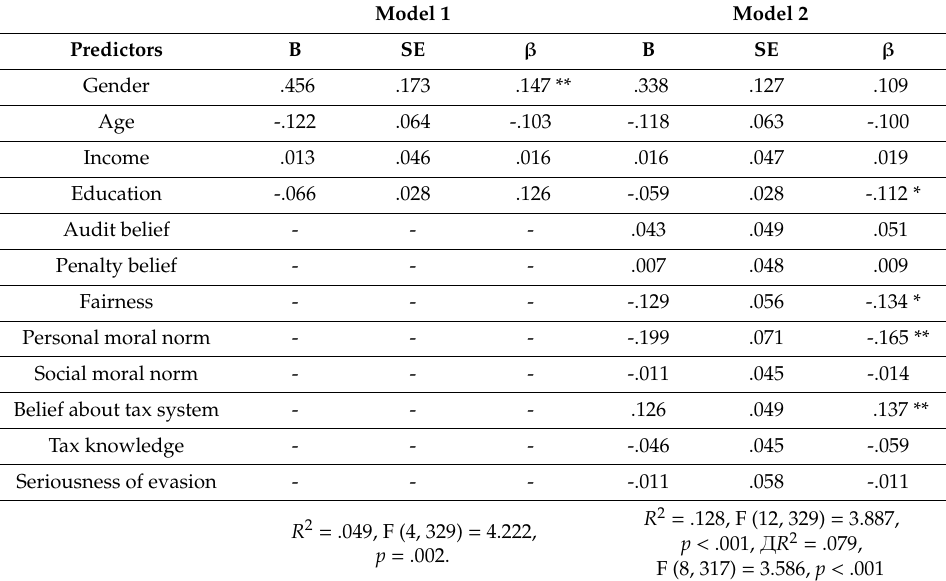
Table 2. Regression analyses for tax